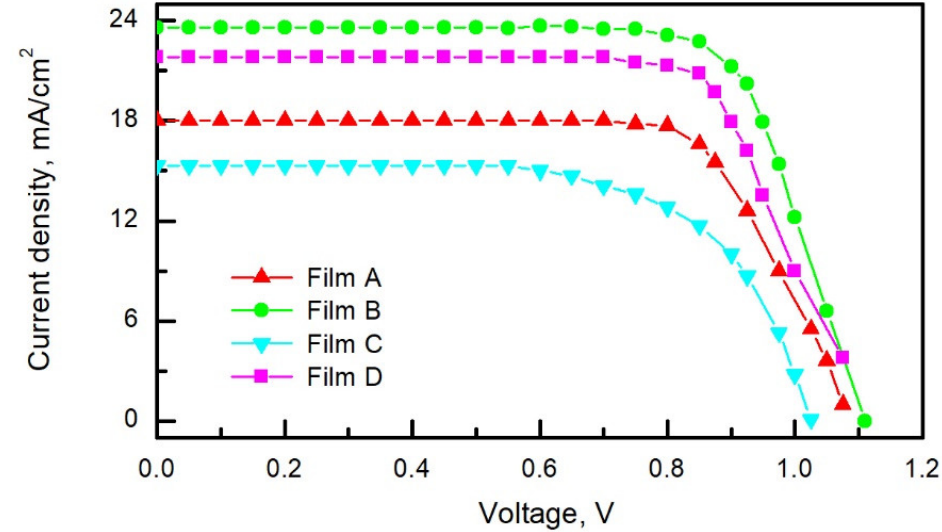
Figure 10. Current–voltage characteristics of the solar cells fabricated on different perovskite films under 100 mW/cm 2 spectral lamp irradiance. Table 3. Photovoltaic parameters of the solar cells on the base of different perovskite films. V oc is the open-circuit voltage; J sc is the short circuit current; FF is the fill factor; PCE is the power-conversion efficiency.